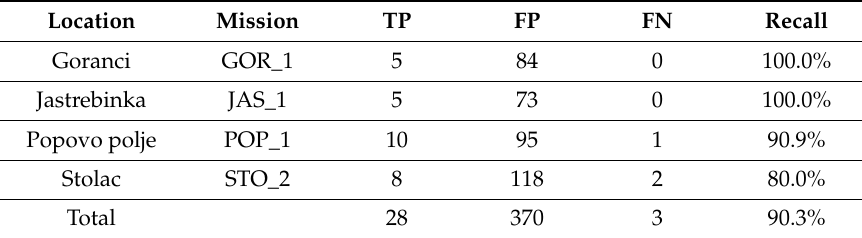
Table 3. ScoreMap to ROI algorithm results.